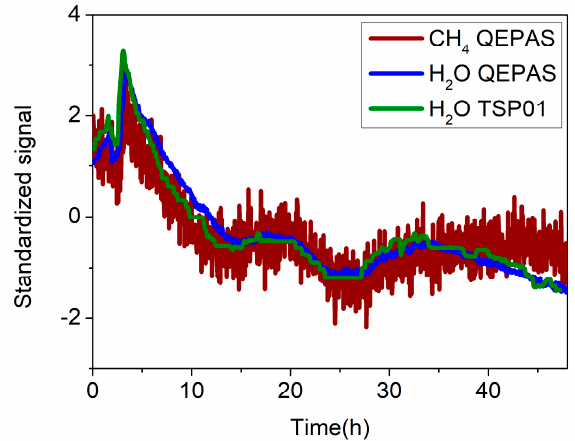
Figure 10. Standardized signals of CH 4 (red line) and H 2 O (blue line) in laboratory air detected with the QEPAS sensor. Standardized absolute humidity detected with the TSP01 hygrometer (green line). Standardization was accomplished with respect to their mean and standard deviation values.